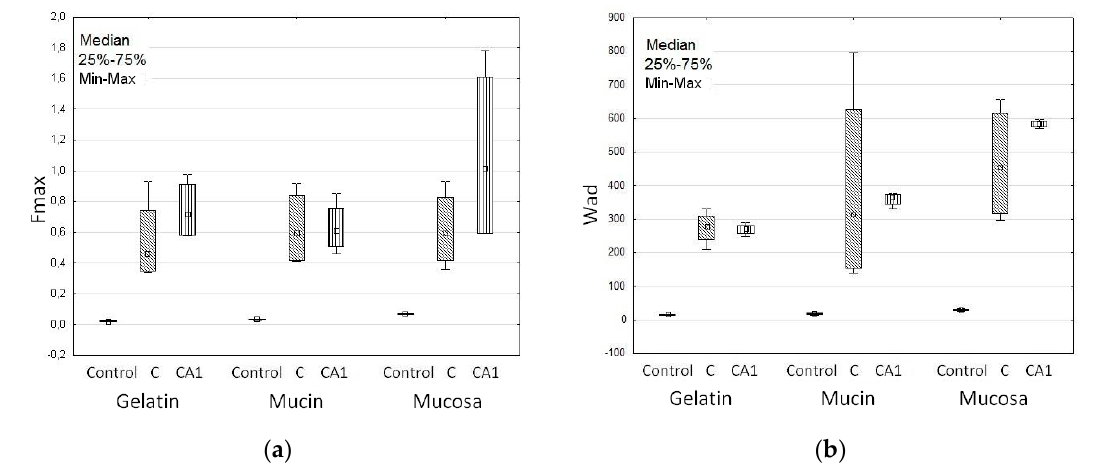
Figure 4. Mucoadhesive features: ( a ) Maximum detachment force (F max ) and ( b ) work of adhesion (W ad ) of non-modified formulation C, cross-linked formulation CA1 and cellulose paper (Control) (median; n = 6).